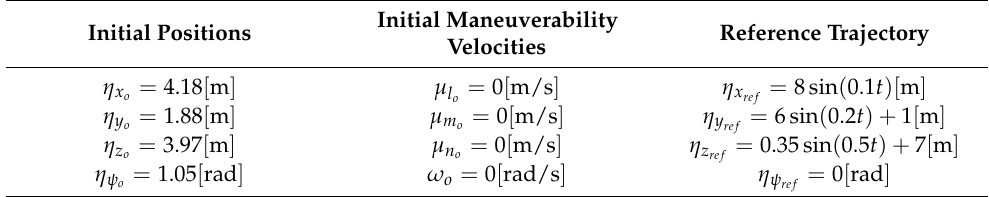
Table 6. Desired reference trajectory in the simulation experiment.